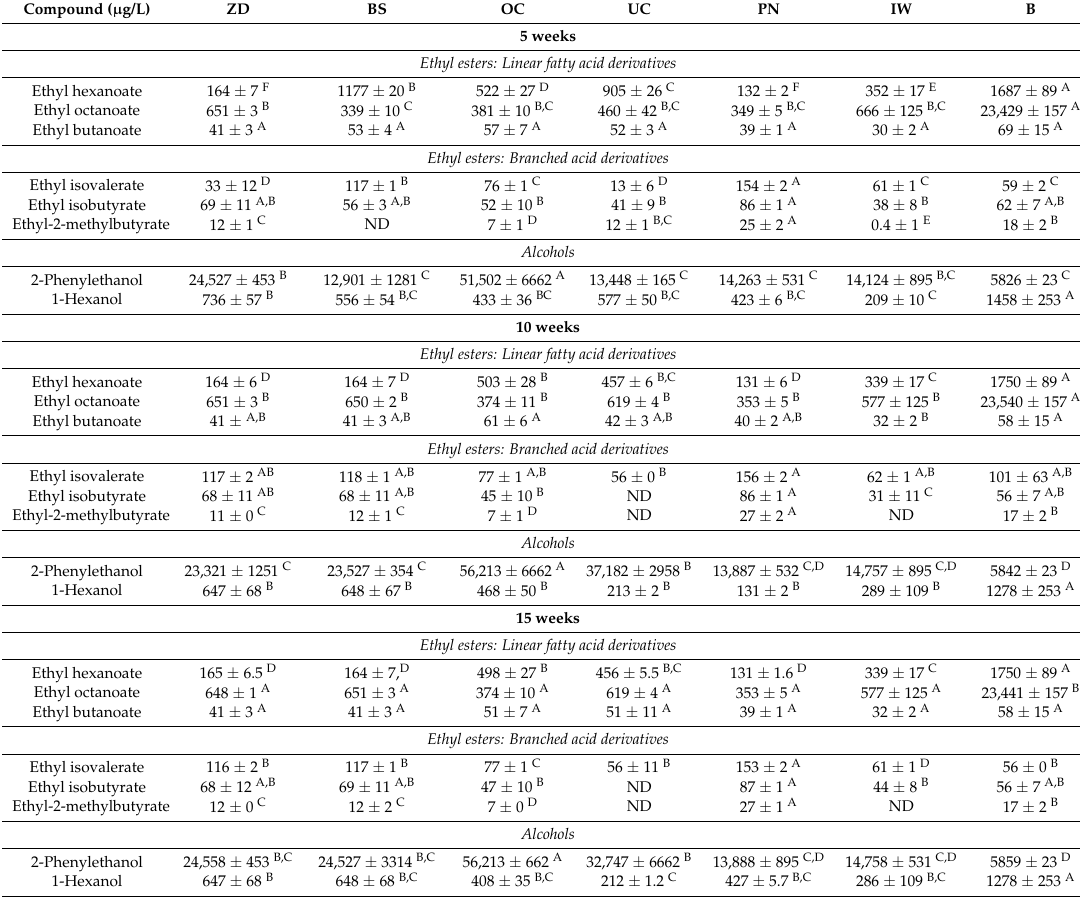
Table 5. Concentration of volatile aroma compounds (VOCs) in sparkling wines at 5, 10 and 15 weeks